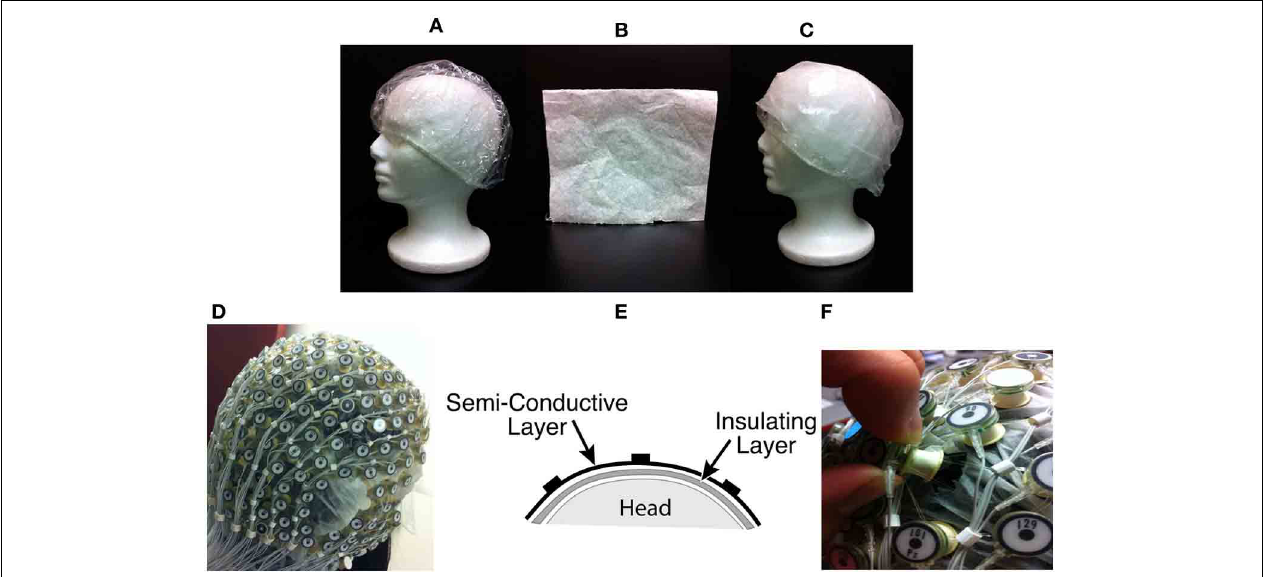
Figure 1D , and then unblock selected channels by removing